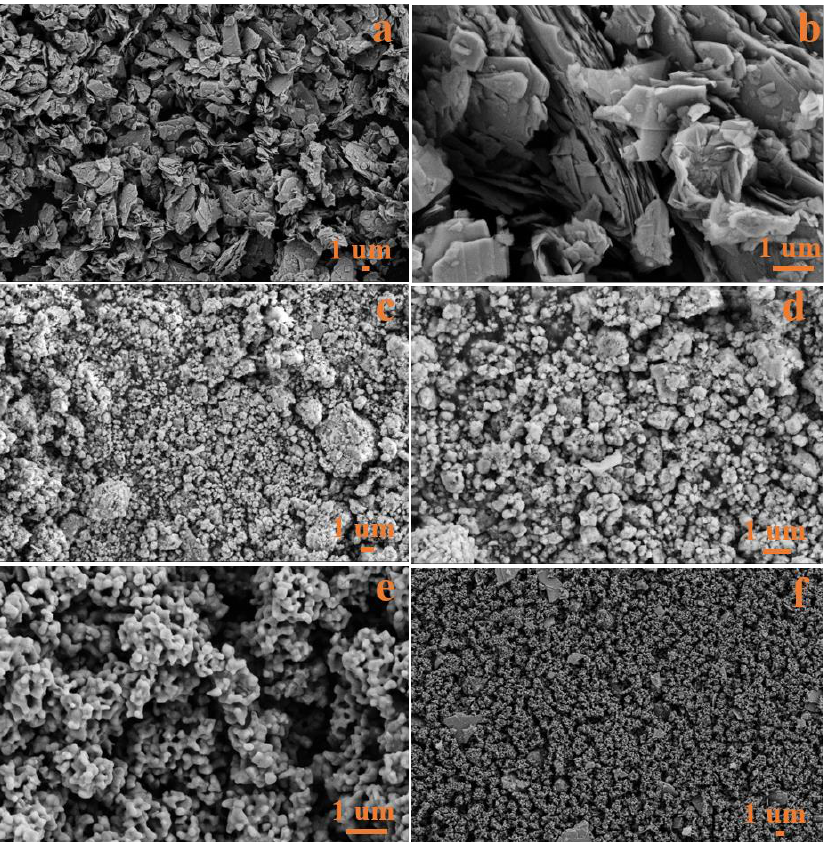
Figure 2. SEM images of the MoS 2 ( a , b ), NiS ( c , d ), Fe 3 O 4 ( e ) and Fe 3 O 4 /MoS 2 /NiS (5%) ( f ) samples.